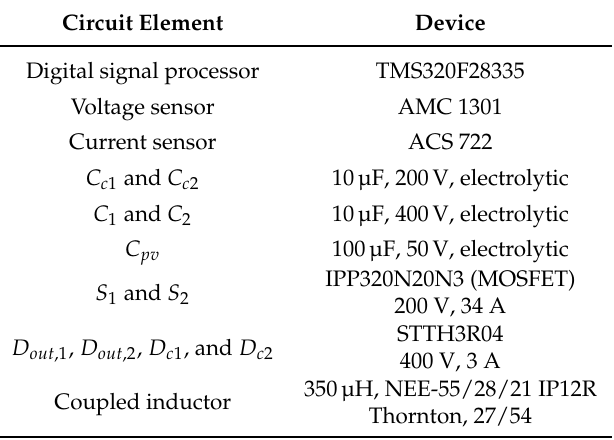
Table 5. Devices used in the